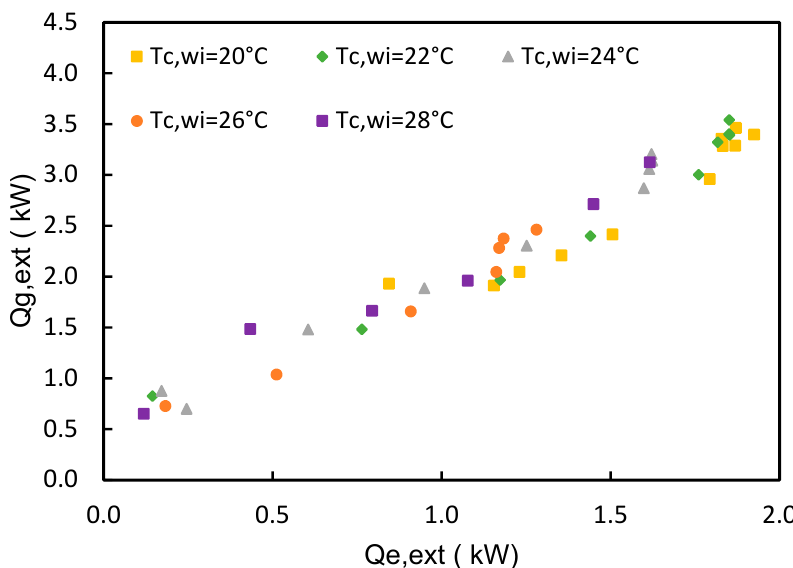
Figure 14. Variation of the generation and cooling powers for the different condensation temperatures.